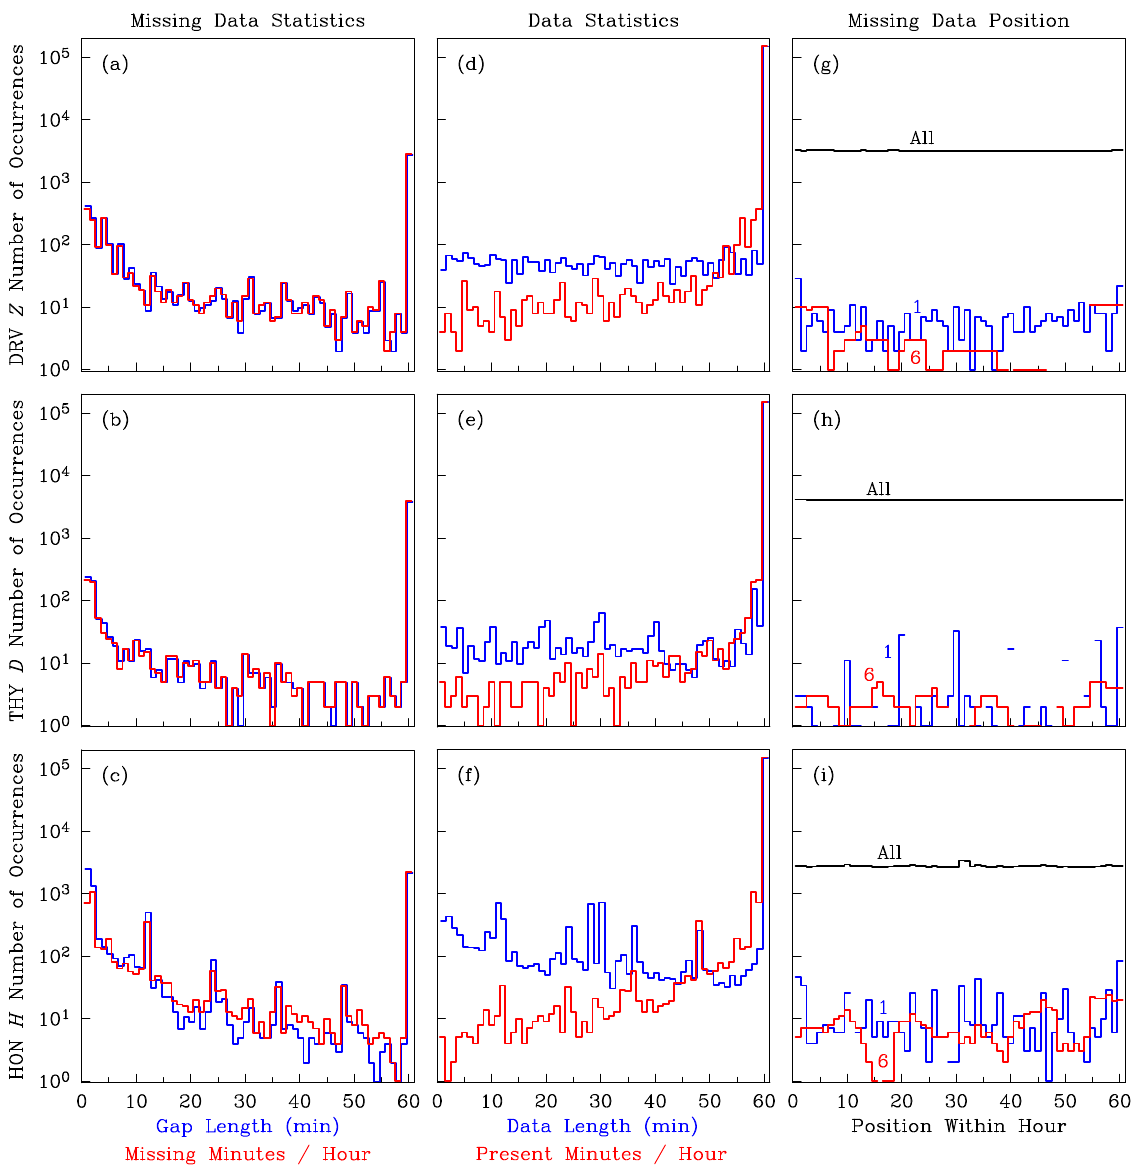
Fig. 2. Data-gap and data-sequence statistics. (a–c) Number of occurrences of data-gap length (blue) and missing minutes per hour (red) for (DRV Z , THY D , HON H ). (d–f) Number of occurrences of data-sequence length (blue) and minutes present per hour (red). (g–i) Position of missing data within each hour; 1 missing minute in an hour (blue), 6 missing minutes (red), all missing minutes (black).